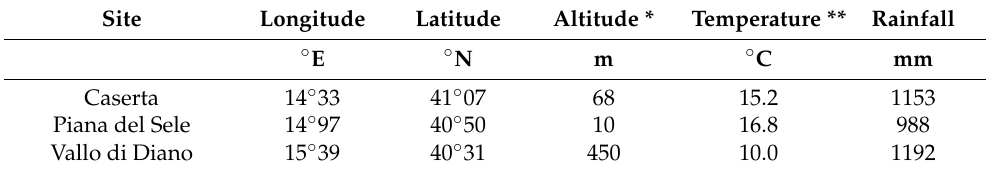
Table 1. Features of the sites.